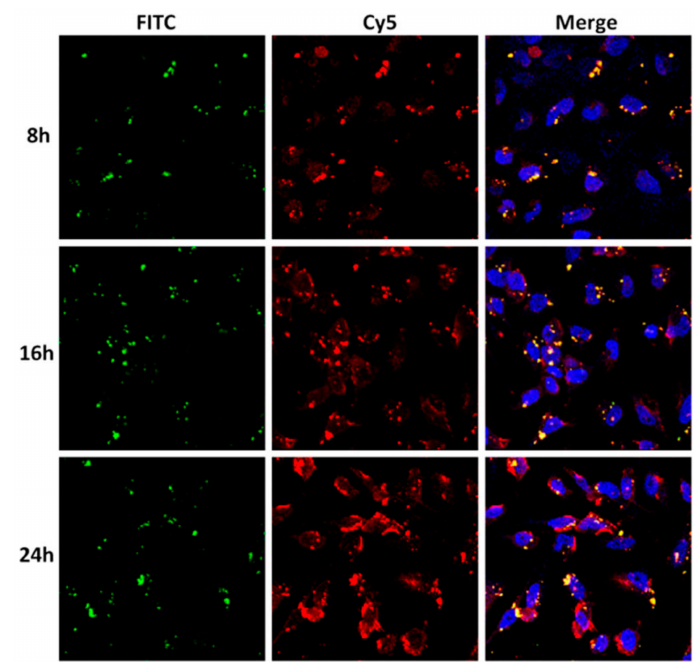
Figure 8. Time-dependent trafficking of the delivery and release processes of PNA delivered by MSNs into HeLa cells. Cy5 and FITC were used to label PNA and MSNs, respectively. PNA, 0.2 µ M; PNA/MSN, 1/20 ( w/w ). Adapted from reference [70] with permission.